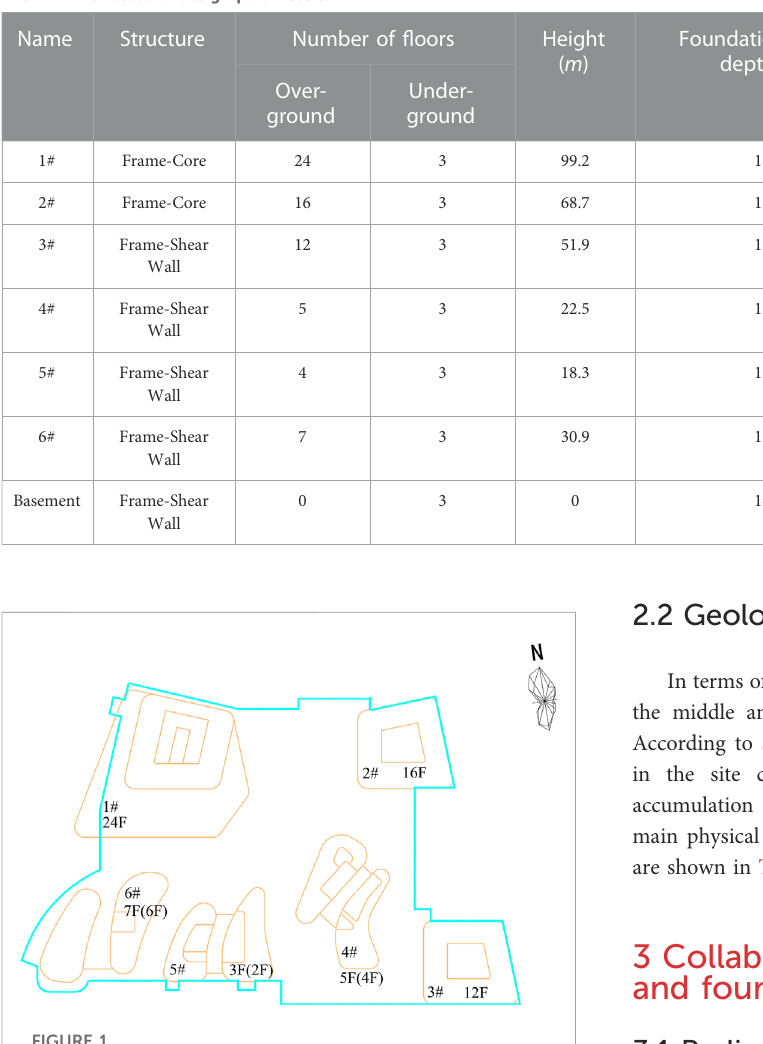
FIGURE 1 Single building plane